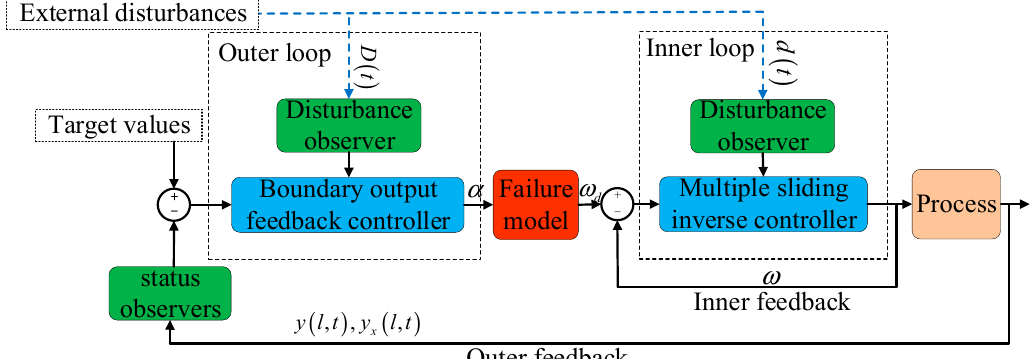
Figure 2. Cascade control of MDRCS.